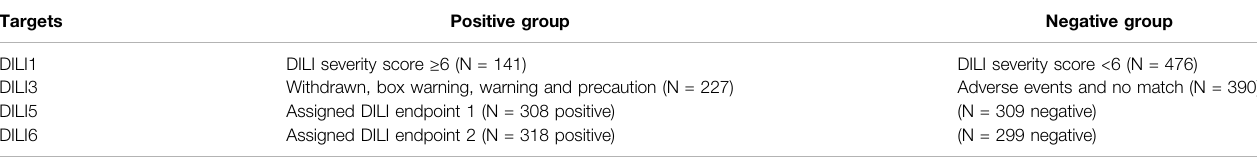
TABLE 2 | Drug-Induced Liver Injury Classi fi cations. Four binary classes of DILI were provided by the CAMDA organizers. DILI1 positive compounds were based on the clinicalseverityscoreassociatedwithlivernecrosis.DILI3positivecompoundswerebasedondrugsalreadyassociatedwithwarningsandprecautionsorthathavebeen withdrawn due toliver toxicity. DILI5 wasarandomassignmentfrom the organizers as anegative control group while theDILI6 classi fi cation wasbased on molecular weight ( > 320 g/mol) to serve as a positive control.